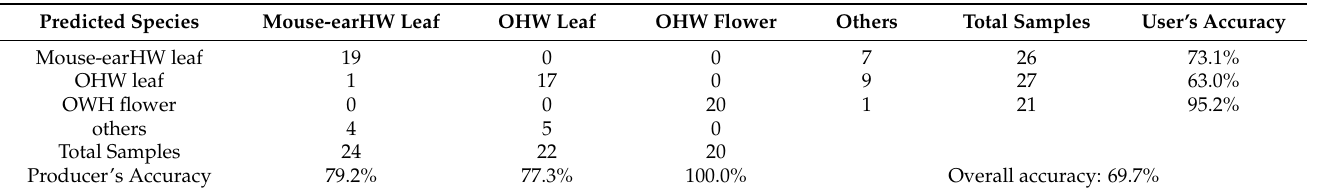
Table 6. Highlight of the accuracy of classification of the targeted weeds using the emulated multispectral profiles for the Sentinel-2 multispectral sensor.